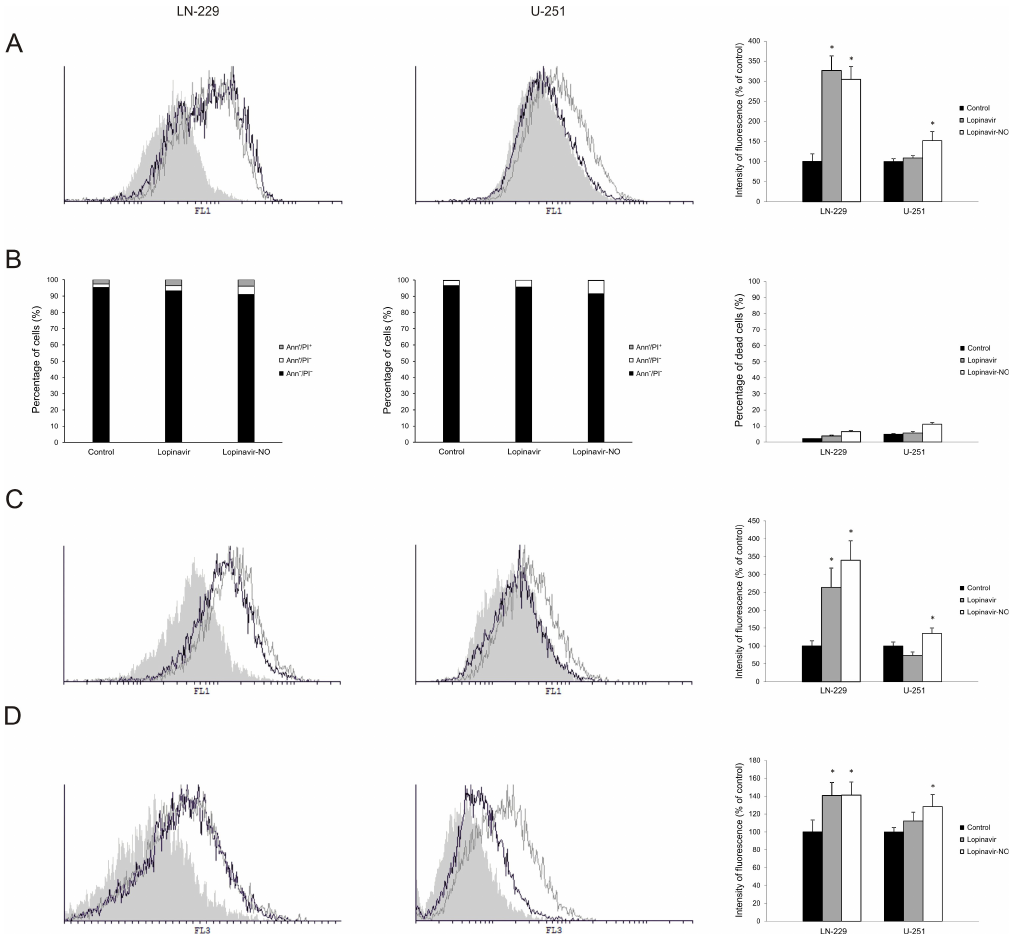
Figure 2. Lopi-NO induced inhibition of proliferation, insignificant apoptosis, and strong autophagy in GBM cell lines. GBM cells were treated with IC 50 doses of both compounds and then subjected to ( A ) carboxyfluorescein diacetate succinimidyl ester (CFSE), ( B ) annexin V-FITC (AnnV)/Propidium Iodide (PI), ( C ) apostat, and ( D ) acridine orange staining. Cells were analyzed by flow cytometry ( A – D ) and representative histograms (left and middle panel) and charts of three independent experiments (right panel) are